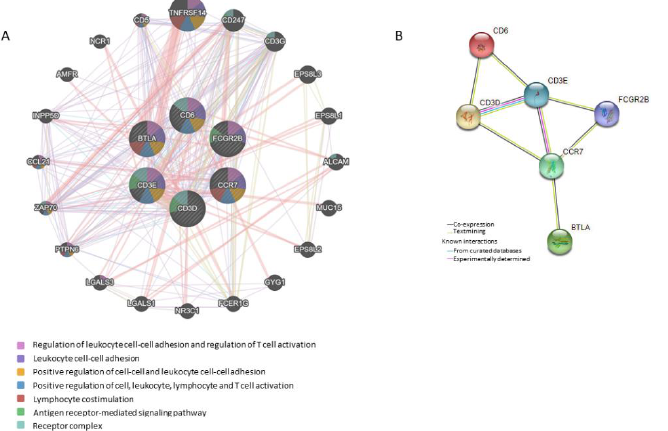
Figure 5. Functional network analysis of the six differentially expressed genes post-RT in LPCa patients. ( A ) Gene interaction network built on the 6-GS using the GeneMANIA database. The different color of the lines connecting the relevant genes depicts the type of interaction, including (1) regulation of leukocyte cell-cell adhesion and regulation of T-cell activation; (2) leukocyte cell-cell adhesion; (3) positive regulation of cell-cell adhesion and positive regulation of leukocyte cell-cell adhesion; (4) positive regulation of cell, leukocyte, lymphocyte and T-cell activation; (5) lymphocyte co-stimulation; (6) antigen receptor-mediated signaling pathway; and (7) receptor complex function. ( B ) Internal interactions between the 6-GS expression products. The corresponding proteins were mapped in the protein-protein interaction (PPI) network using the STRING database. Nodes and edges represent proteins and their interactions, respectively. Filled, colored nodes represent query proteins and first shell of interactors with known or predicted 3D structures. Turquoise and pink edges show known interactions extracted from curated databases or those experimentally determined, respectively. Yellow edges represent text-mining interactions, black edges indicate that the respective proteins are